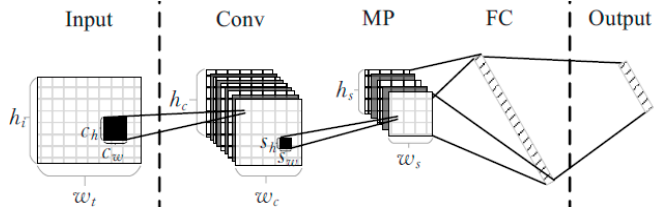
Figure 4. Convolutional neural network (CNN) network structure.